Question: Give a one-sentence summary of this figure.
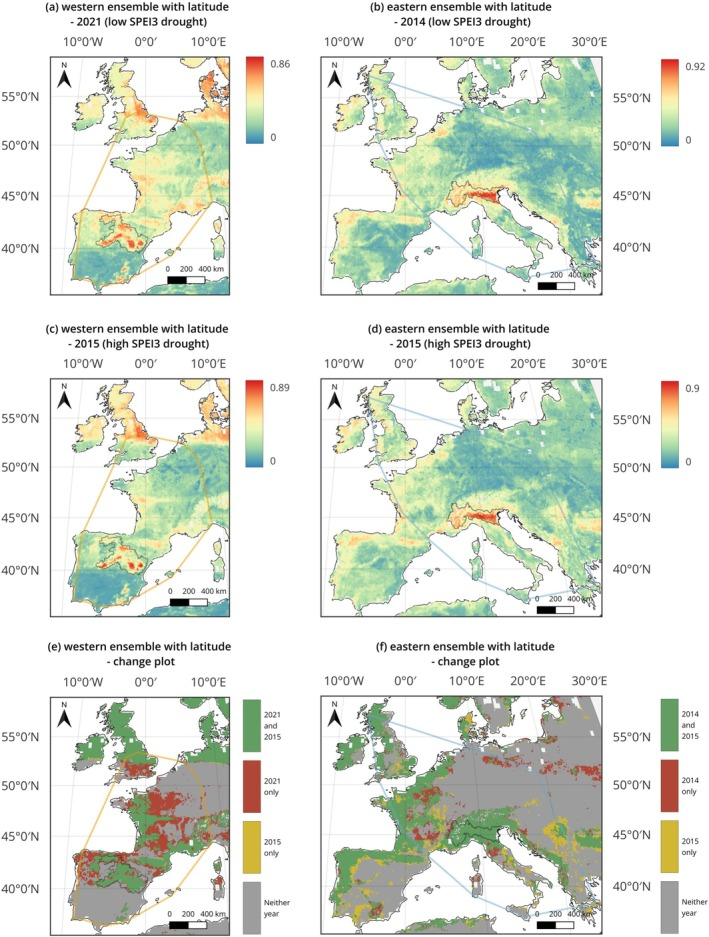
Answer: Ensemble spatial predictions for the western (a, c, e) and eastern (b, d, f) migration routes, with latitude included as a predictor. Heat maps for years of low (a & b) and high (c & d) SPEI3 drought indicate stopover probability (see keys). Key regions of predicted stopover use are outlined by black borders. For change maps (e & f), colours indicate whether stopovers were predicted across one, both or neither years (see keys). Polygons denote the area in which models were trained. Maps are projected using the Mollweide projection (ESRI: 54009).